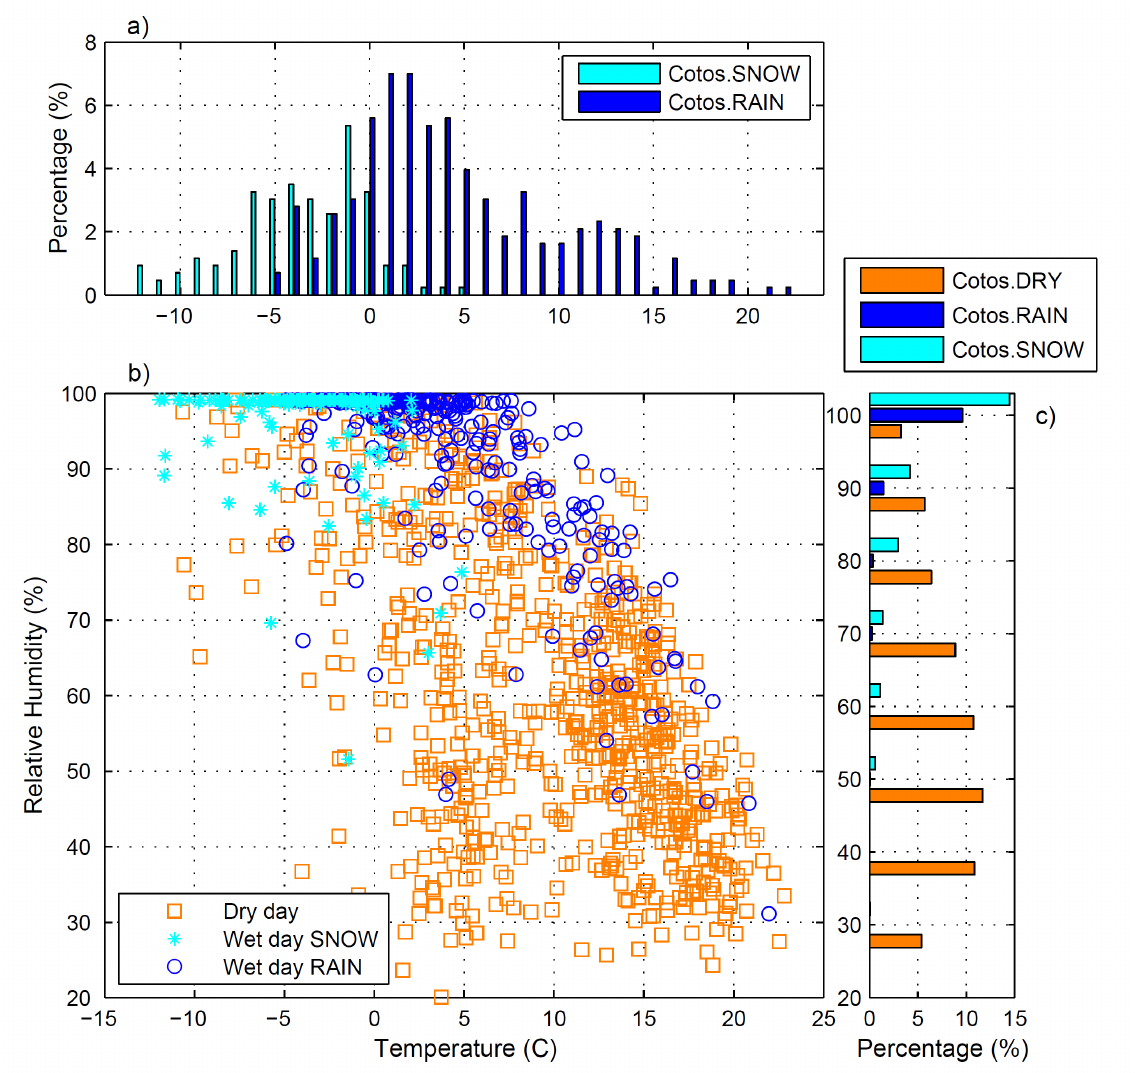
Figure 12. ( a ) Bar plot of rain (Cotos.RAIN) and snow (Cotos.SNOW) observed using a manual rain gauge at Cotos for different values of daily mean air temperature; ( b ) Scatter plot of daily relative humidity against daily temperature for days with precipitation under 1 mm (squares), days with snow precipitation above than 1 mm (asterisks) and days with rain precipitation above 1 mm (circles) at Cotos; ( c ) Bar plot of percentage of days with precipitation under 1 mm (Cotos.DRY), days with snow precipitation (Cotos.SNOW) and days with rain precipitation (Cotos.RAIN) above 1 mm and mean daily relative